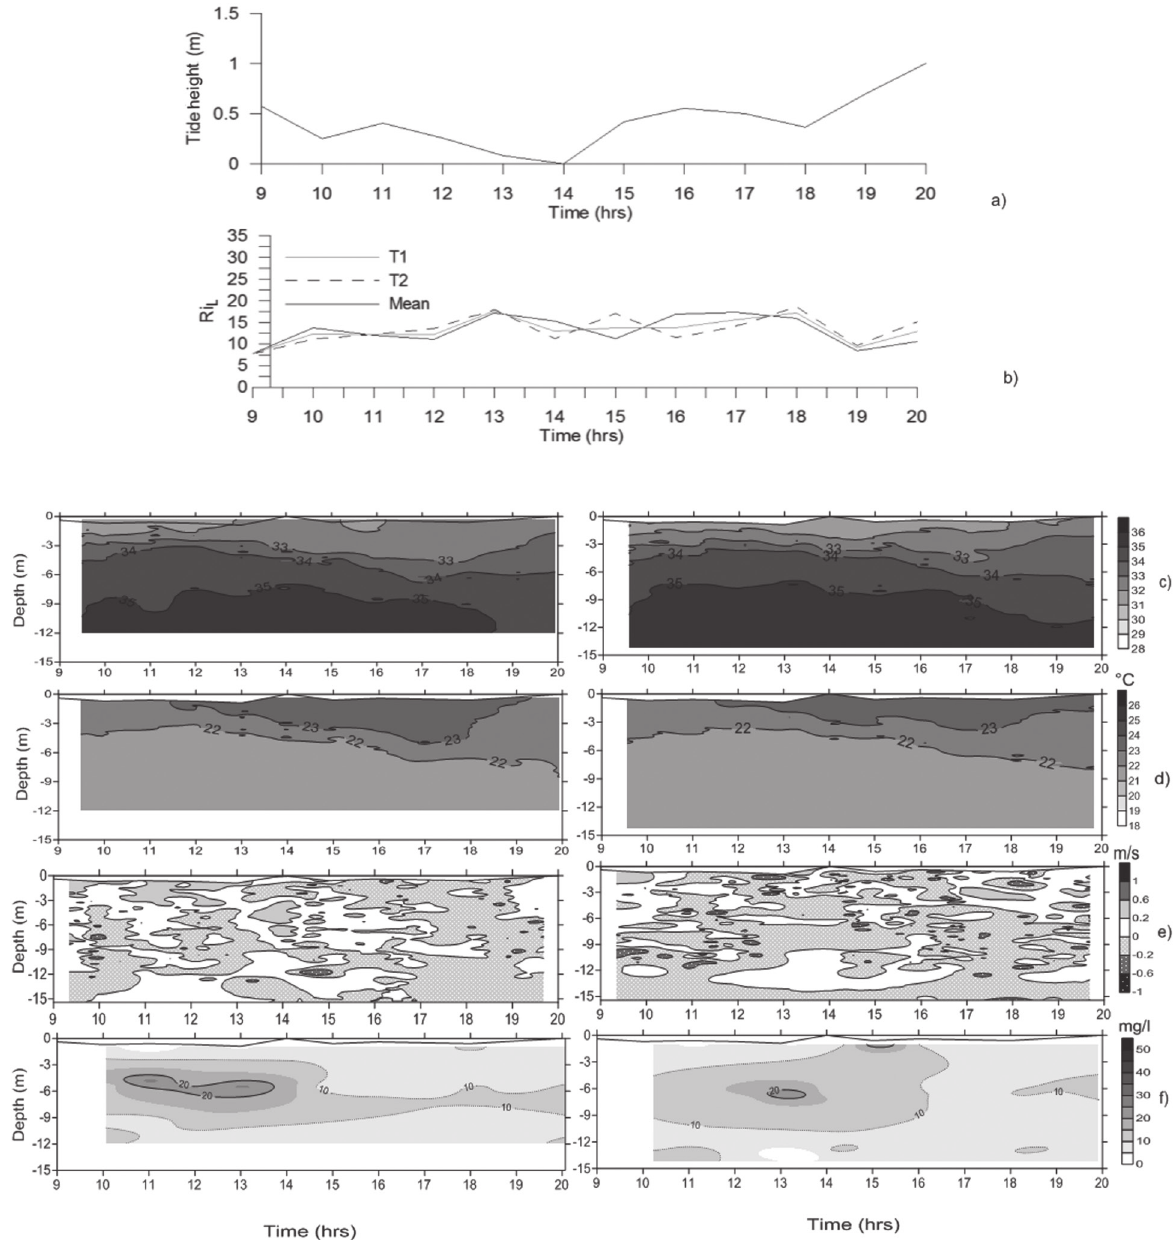
Figure 2 - Temporal profiles of QS (neap cycle during the dry season - 09/15/2010); a) tide elevation (m); b) Layer Richardson number; c) salinity (PSU) d) temperature (°C); e) longitudinal velocity (m/s); f) SPM (mg/L);. Left column is station T1 and right column station